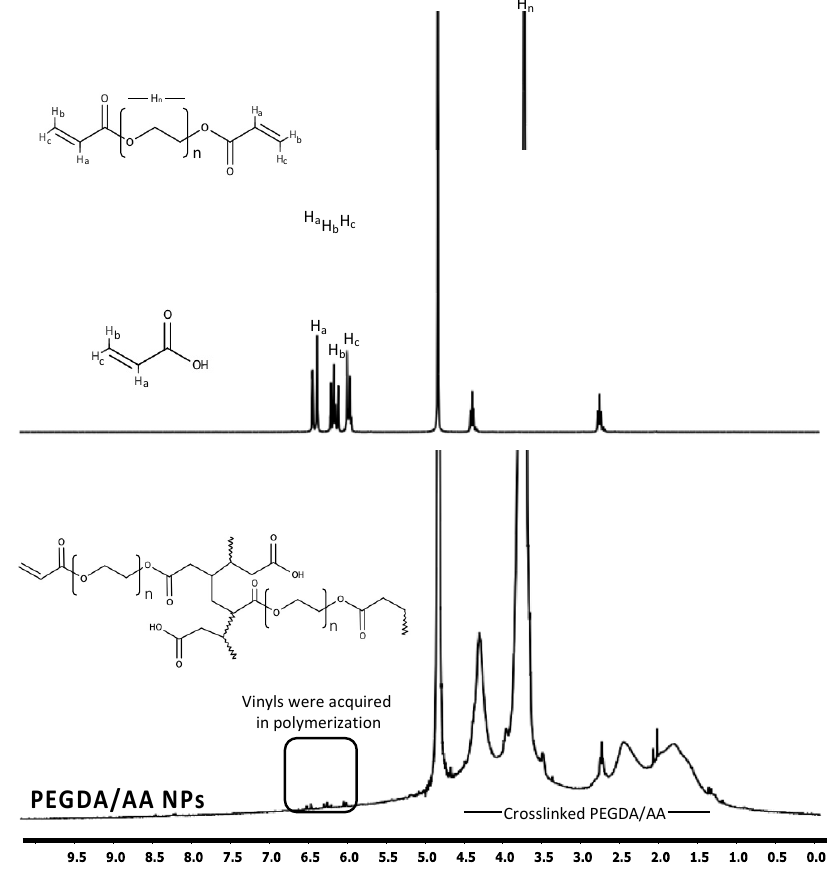
Figure 2. 1 H-NMR spectra of PEGDA, AA and PEGDA/AA NPs.